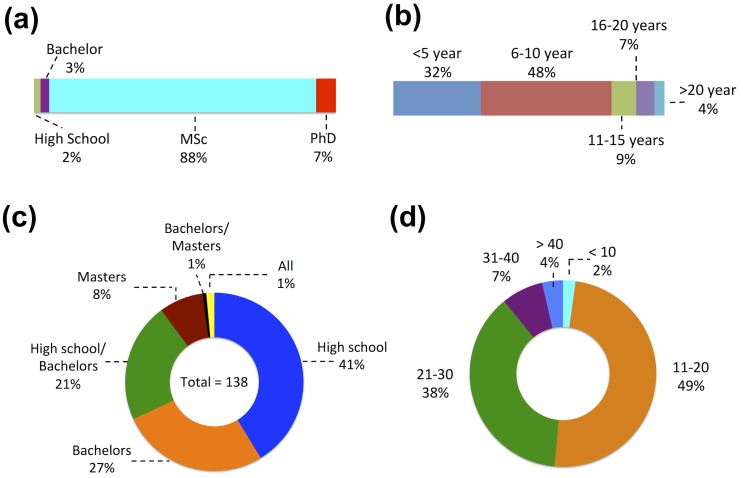
(a) Highest education degree of respondents, (b) Respondents’ teaching experience duration, (c) Level of courses offered in the chemistry labs represented in this survey, and (d) Number of students in each lab session.